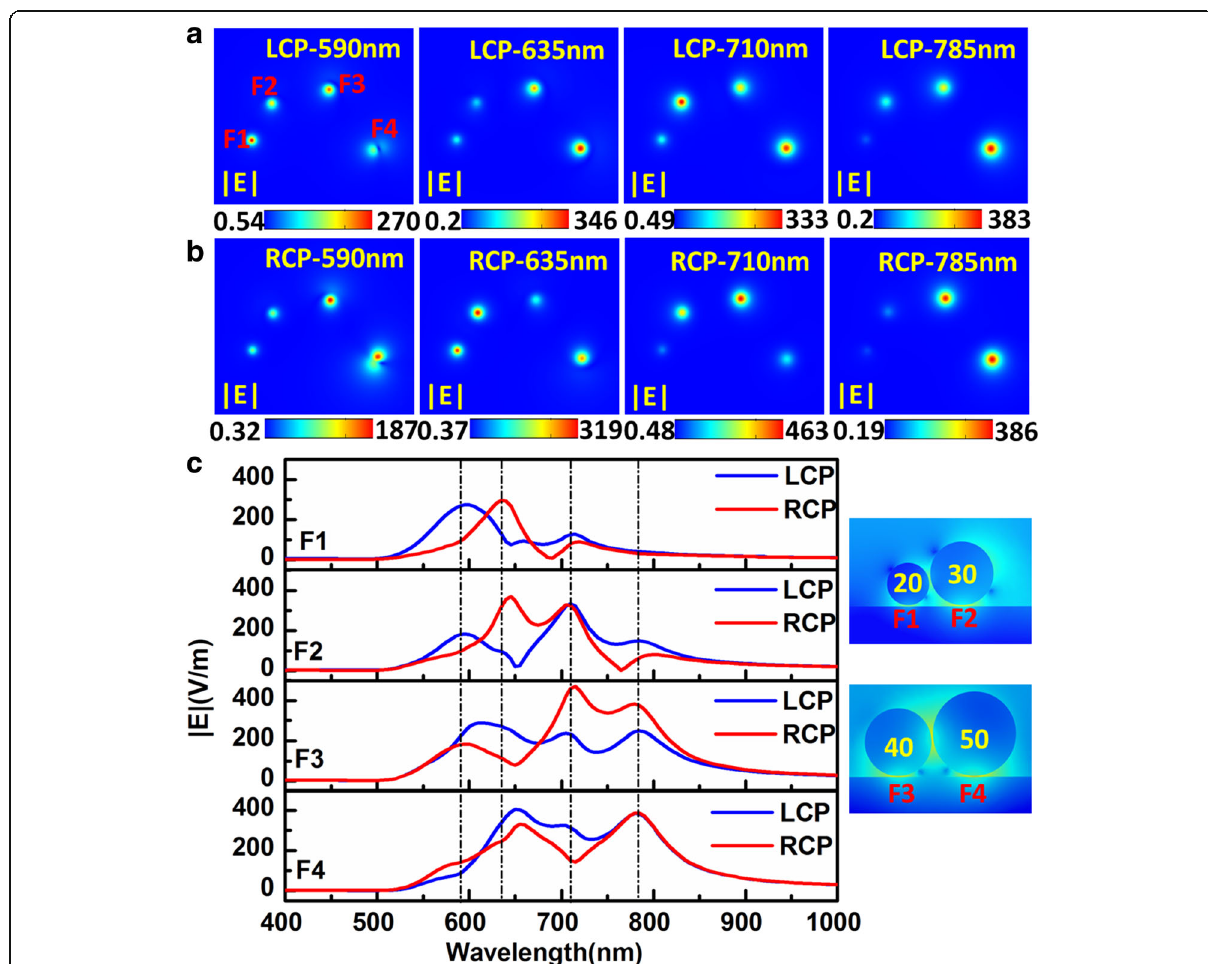
Fig. 2 The electromagnetic energy focusing effect in the Ag chiral particle chain-film system. a , b The electric near-field distributions in the x - y plane in the middle of gap between chiral particle-film at different resonant peaks for the system excited by LCP ( a ) and RCP ( b ) light, respectively. Each picture corresponds to the marked resonant peak. c Electric field enhancements in the gaps F1, F2, F3, and F4, indicated in the right pictures (and in a as well) show huge differences at resonant peaks. The blue and red solid lines represent electric field enhancement for LCP and RCP light. The vertical dashed lines from left to right correspond to the peaks at 590, 635, 710, and 785 nm,